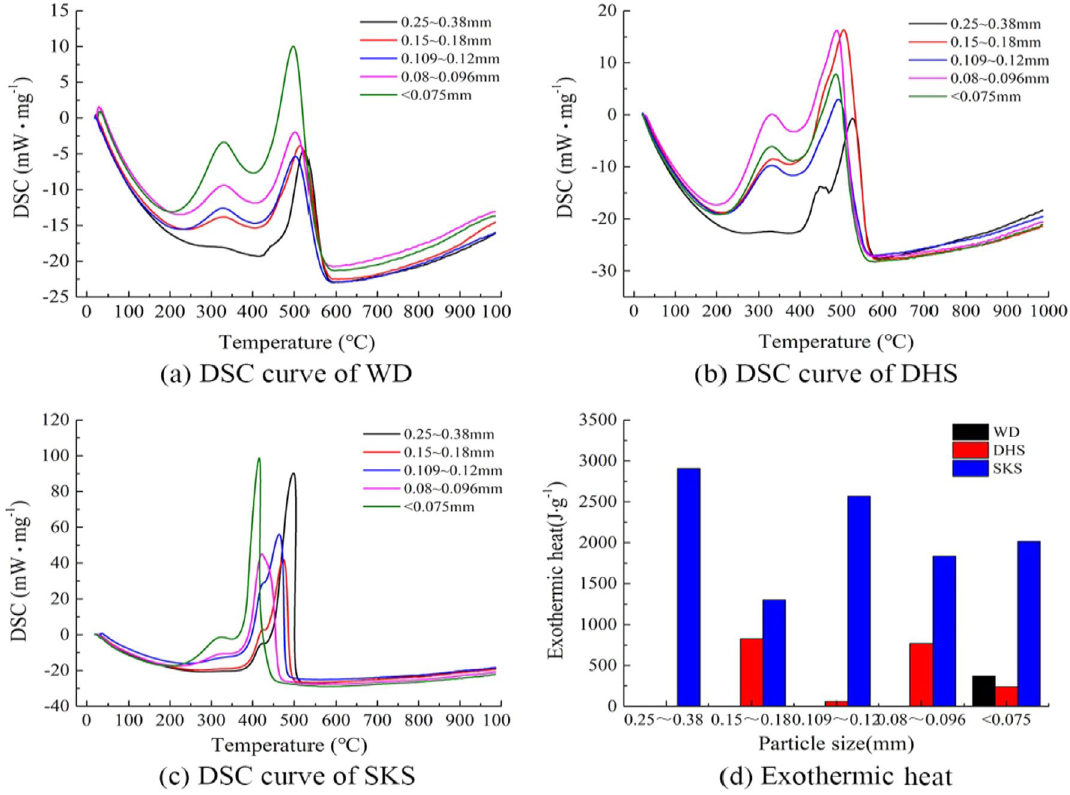
Fig. 12 DSC curves and exothermic heats of coal samples with different particle